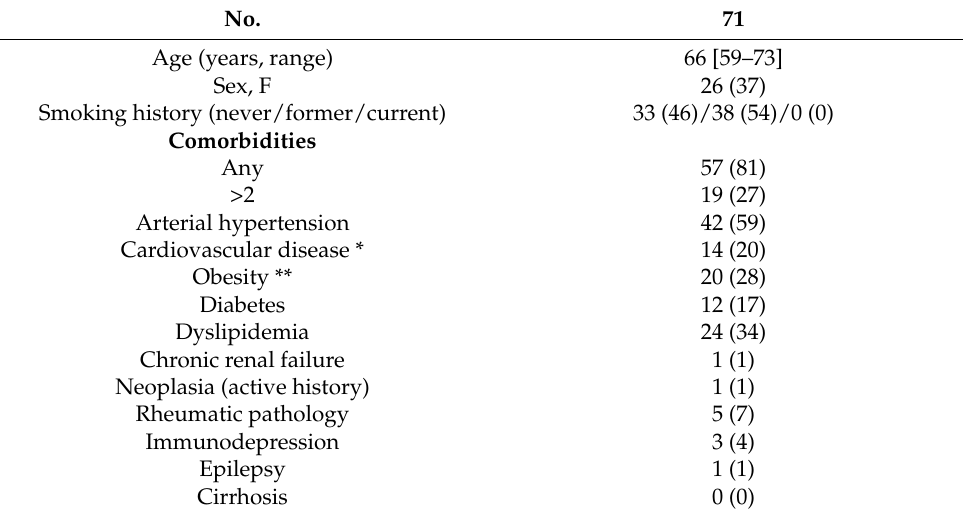
Table 1. Demographic and clinical features of the 71 patients who survived severe COVID-19 pneumonia [25] and were included in the study and followed up to 12 months after discharge.